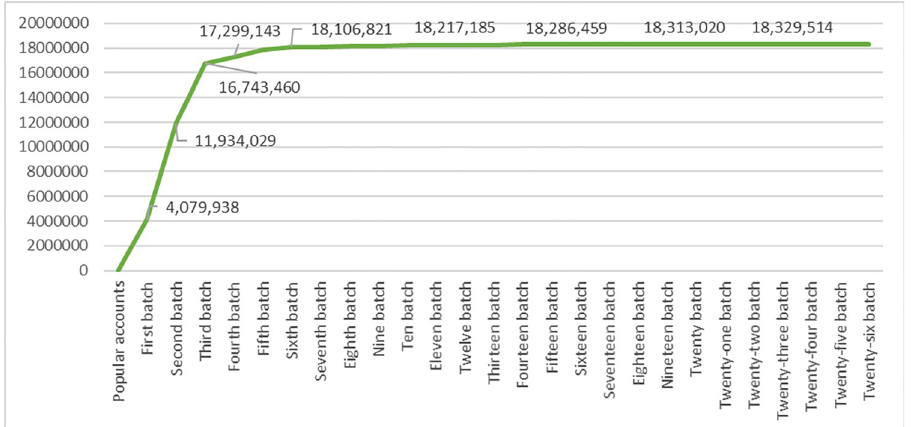
Fig 2. The accumulated number of active South Korean users after each